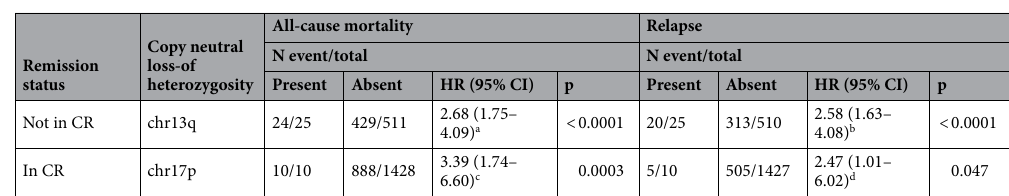
Table 2. Association between copy-neutral loss of heterozygosity in chr13q or chr17p and post-HCT outcomes in patients with AML. a Model was adjusted for recipient race, Karnofsky Performance Status scores, study cohort, GvHD prophylaxis, donor–recipient CMV serostatus matching, and graft type. b Model was adjusted for Karnofsky Performance Status scores, and graft type. c Model was adjusted for recipient age, donor age, GvHD prophylaxis, Karnofsky Performance Status scores, donor-recipient CMV serostatus matching, and stratified on recipient sex, conditioning intensity, graft type, and year of transplant. d Model was adjusted for conditioning intensity, donor sex, study cohort, and stratified on Karnofsky Performance Status